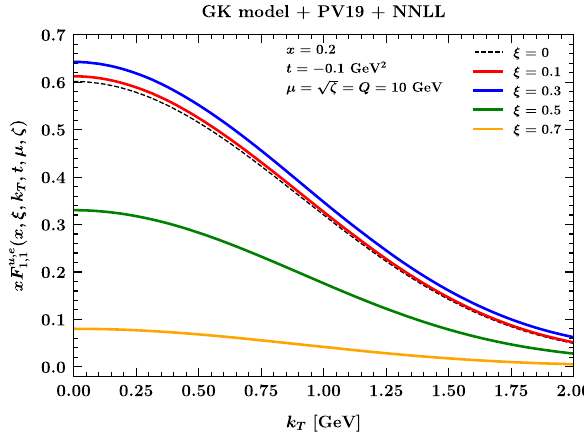
Fig. 5 xF u , e (up quark) vs k T at x = 0 . 2, t = − 0 . 1 GeV 2 , and √ 1 , 1 ζ = 10 GeV for five different values of the skewness: Q = μ = ξ = 0 (blacked dashed curve), ξ = 0 . 1 (solid red curve), ξ = 0 . 3 (solid blue curve), ξ = 0 . 5 (solid green curve), and ξ = 0 . 7 (solid orange curve). F u , e is computed at NNLL accuracy (see text) using 1 , 1 the GK model for the GPDs and the PV19 determination for the non- perturbative transverse component